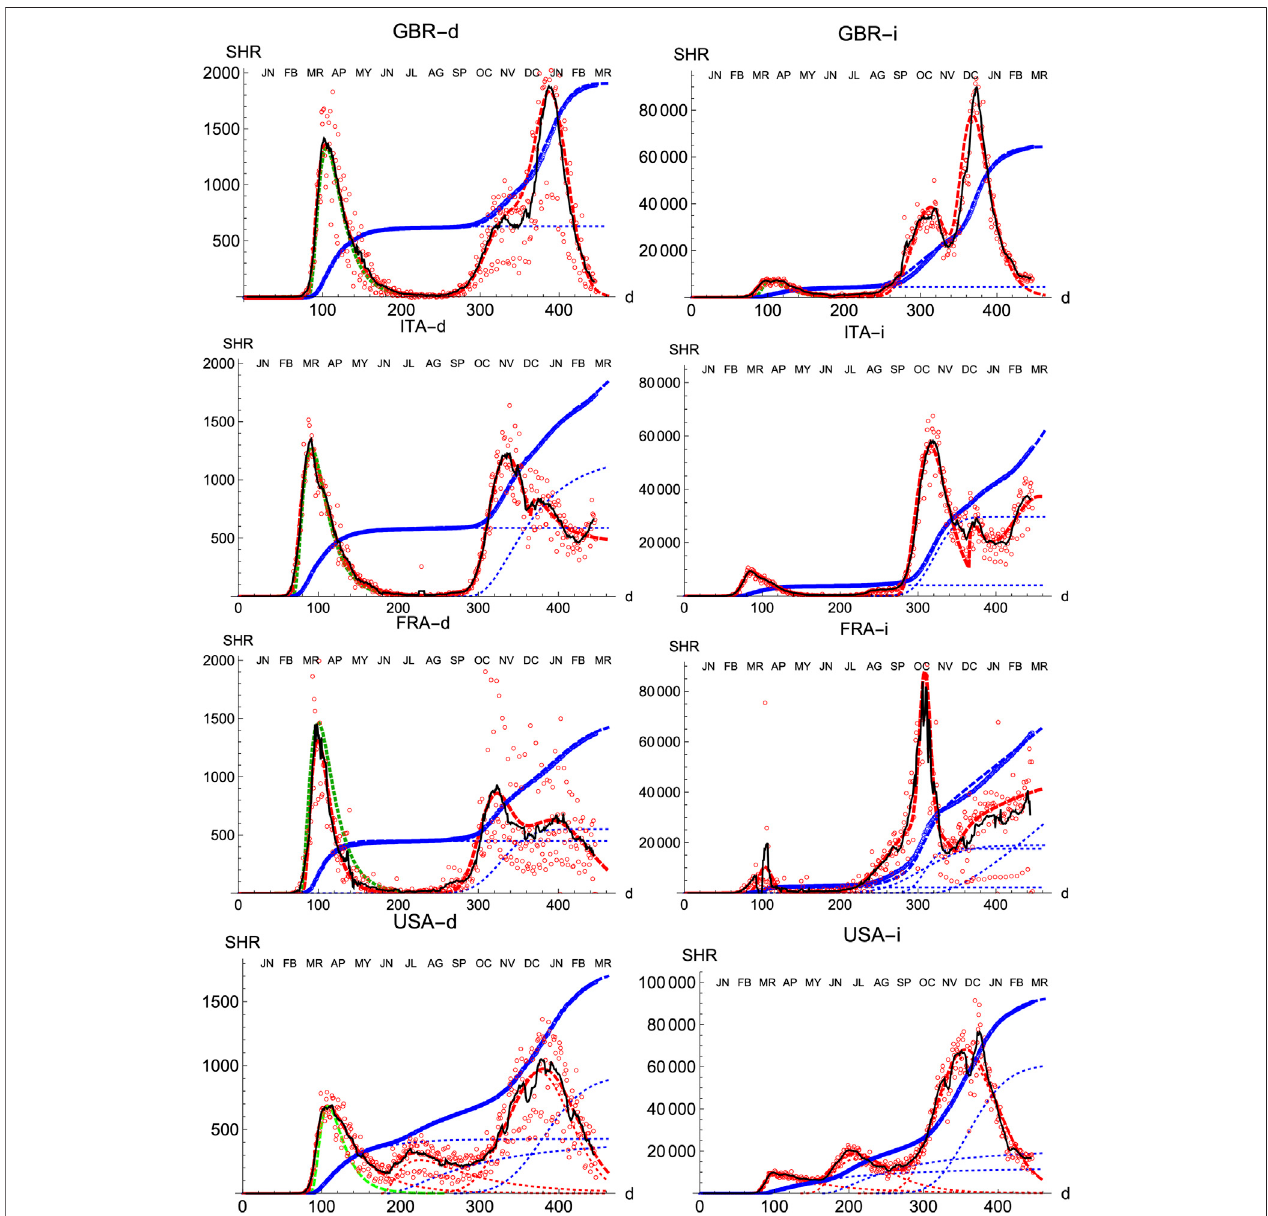
FIGURE 3 | SHR/Other countries (I). Symbols as in Figure 1 . Changes in methodology took place in United Kingdom (GRB) on May 20th and July 3rd, and in France (FRA) on May